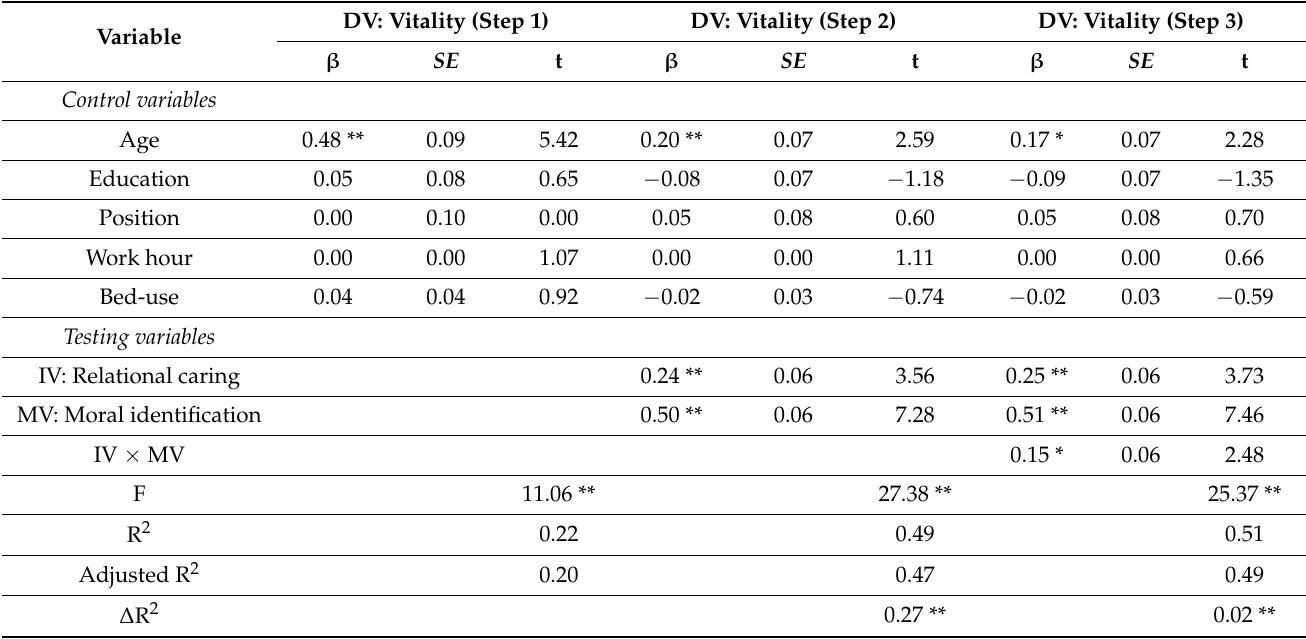
Table 3. The result of regression analysis.